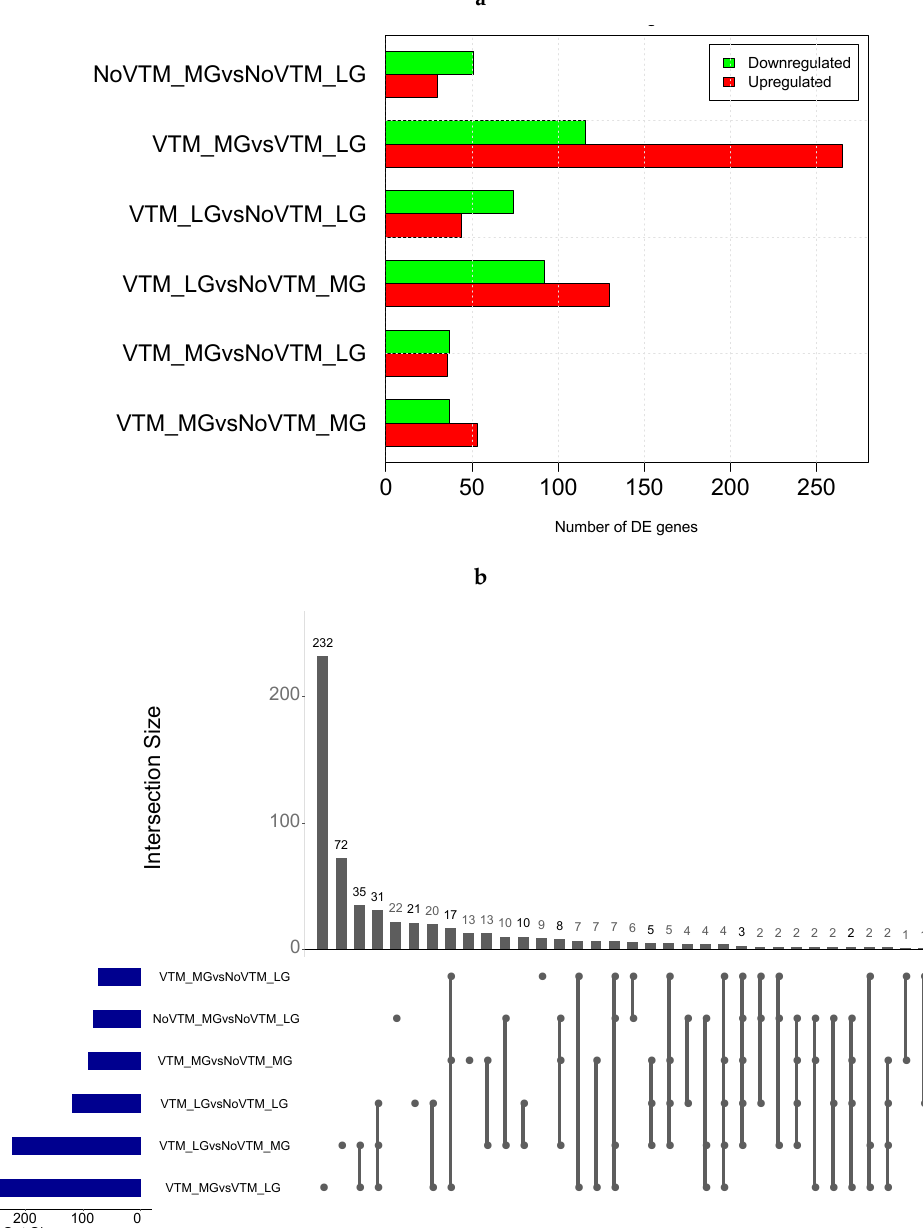
Figure 1. Differential gene expression in the livers of fetuses from heifers receiving or not receiving vitamin–mineral supplementation (VTM or NoVTM) and fed to achieve different rates of gain (low gain (LG) or moderate gain (MG)) during early gestation. ( a ) Number of differentially expressed genes (DEGs) across contrasts. ( b ) The UpSet plot represents the intersection between the sets of DEGs from different contrasts. Each vertical bar shows the number of genes in the intersection. The dot plot reports the set participation in the intersection, and the horizontal bar graph reports the set sizes (totals of DEGs). The treatments were arranged as follows: NoVTM_LG—no vitamin and mineral supplementation and low gain; VTM_LG—vitamin and mineral supplementation and low gain; NoVTM_MG—no vitamin and mineral supplementation and moderate gain; and VTM_MG—vitamin and mineral supplementation and moderate gain.